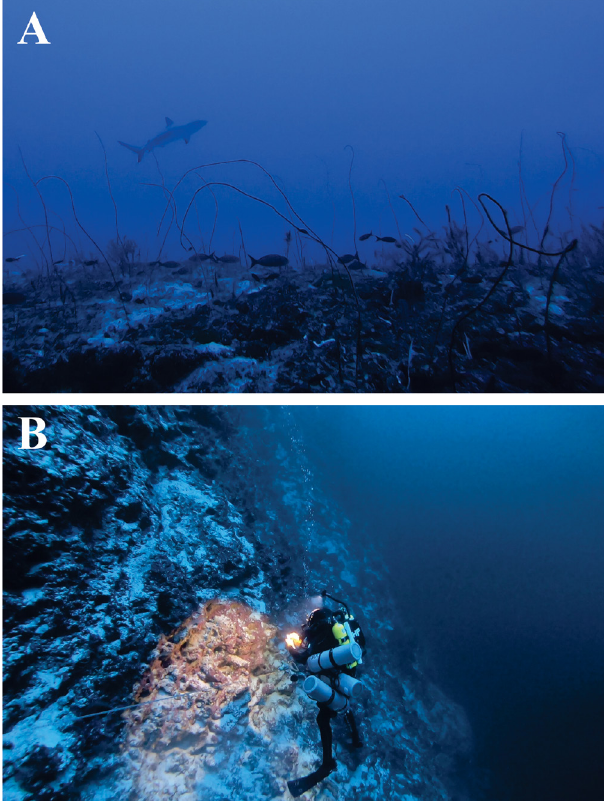
FIGURE 3 | Lower mesophotic (below 90 m depth) ecosystems explored through technical rebreather diving around the Fernando de Noronha Archipelago. A. The insular shelf edge; and B. The steep